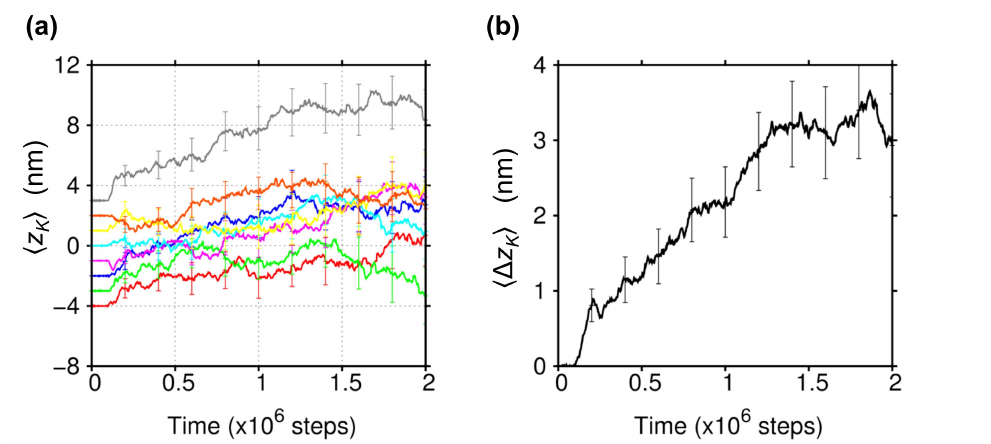
Figure 2. Ensemble behavior of KIF1A movement along the MT. ( a ) Average time-course of (cid:104) z K (cid:105) started from each of the eight initial positions ( z K ( 0 ) = − 4, − 3, − 2, − 1,0, + 1, + 2, + 3 nm, colored in red, green, blue, magenta, cyan, yellow, orange, and gray, respectively). For averaging, we excluded the trajectories where KIF1A moved far from the MT ( z K > 10 nm). Binding was judged to occur when z K < 1 nm. The time course data before unbinding were used to calculate the average. ( b ) Ensemble average of the z -displacement of KIF1A as a function of time, (cid:104) ∆ z K ( t ) (cid:105) ≡ (cid:104) z K ( t ) − z K ( 0 ) (cid:105) , obtained from the trajectories where KIF1A binding was observed (total 1218 runs). Error bars indicate the statistical uncertainty (the standard error of the mean) at the 68% confidence